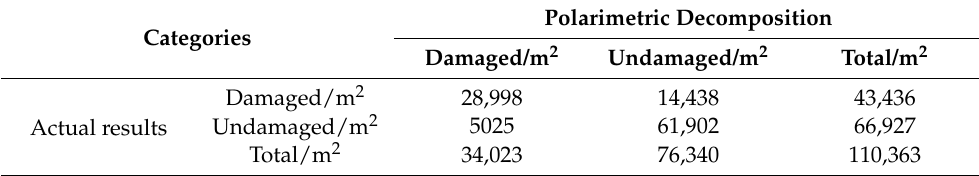
Figure 11. Building damage assessment map. ( a ) Damage assessment map obtained by polarimetric decomposition; ( b ) Overlay of Figure 11a based on optical image obtained using Google Earth Engine (https://earthengine.google.com/), and accessed on 10 October 2021. Table 3. Accuracy verification of polarimetric